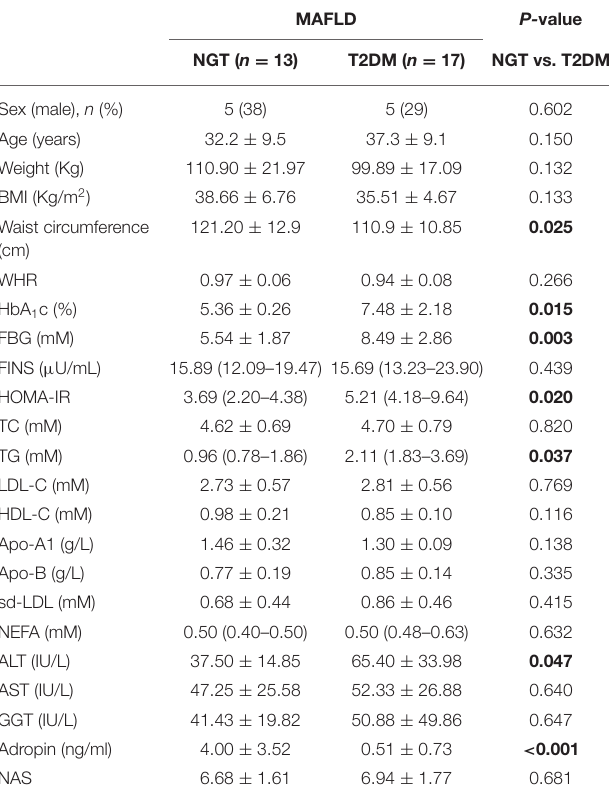
TABLE 2 | Anthropometric parameters and biochemical indexes among NGT and T2DM groups in MAFLD